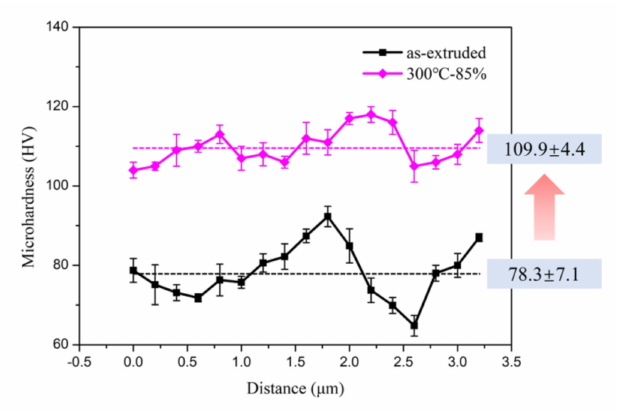
Figure 5. Microhardness (HV) of AlN / Al composites before and after rolling for 85% thickness reduction at 300 ◦